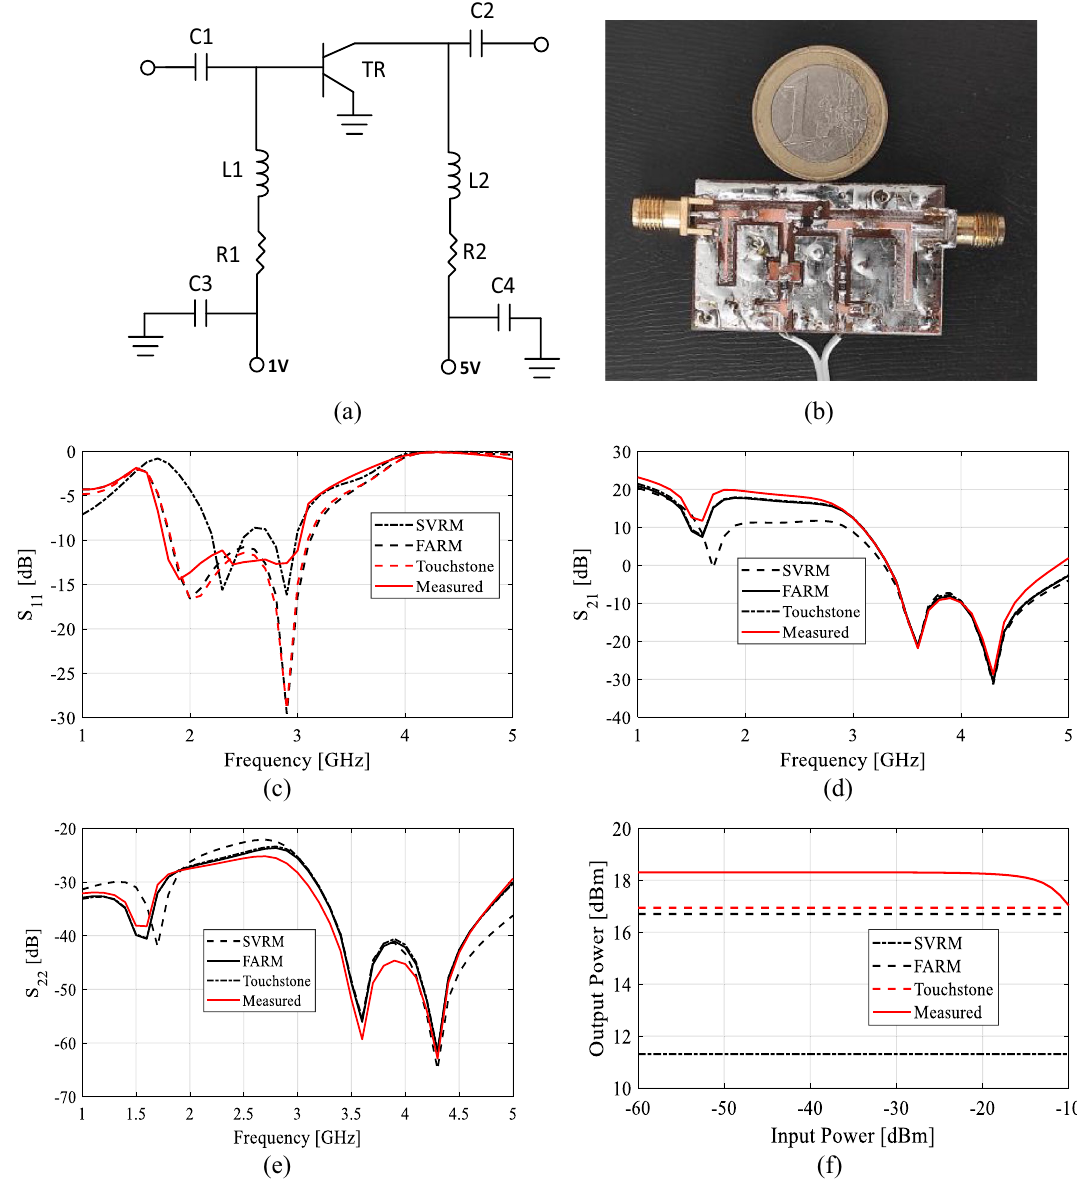
Figure 8. Low-noise amplifier designed using the proposed FARM surrogate: ( a ) schematic diagram of the SSA, ( b ) photograph of the circuit prototype (the SSA designed using the FARM model with two internal layers), comparison of simulated results from Touchstone, FARM and SVRM model with measured ( c ) S 11 , ( d ) S 21 , ( e ) S 12 , ( f ) Pout @ 2.4 GHz, characteristics of